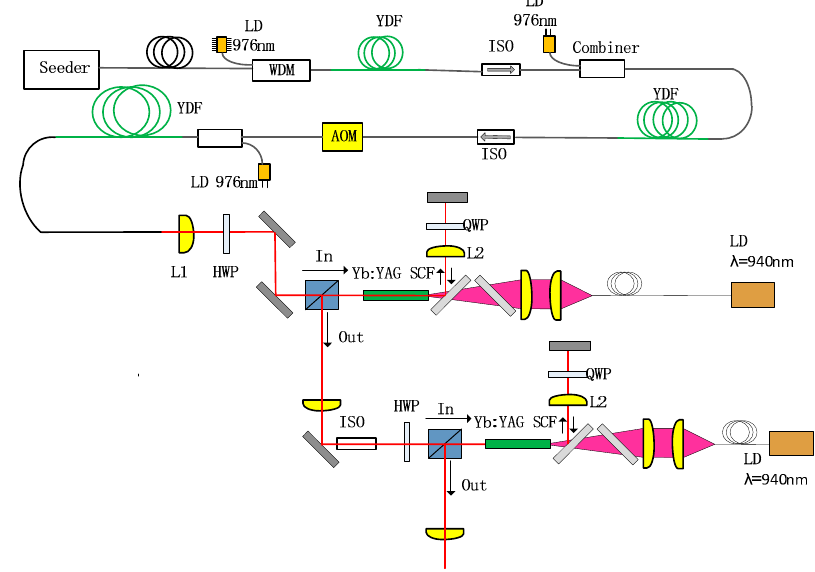
Figure 1. Schematic diagram of the high energy picosecond master oscillator power amplifier (MOPA) system.